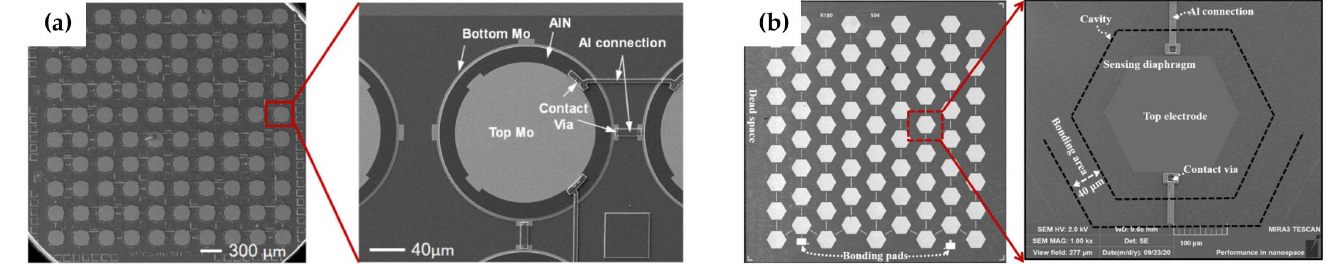
Figure 3. MEMS hydrophones. ( a ) Original circular architecture from Xu et al. [26]. ( b ) Honeycomb architecture from Jia et al. [27].